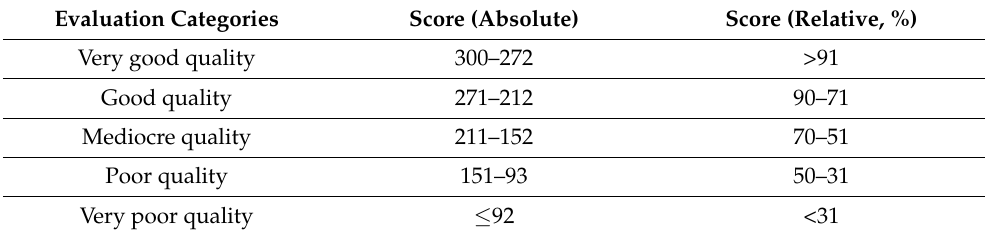
Table 2. Evaluation categories (modified from Wahl and Apfelbacher [41]).